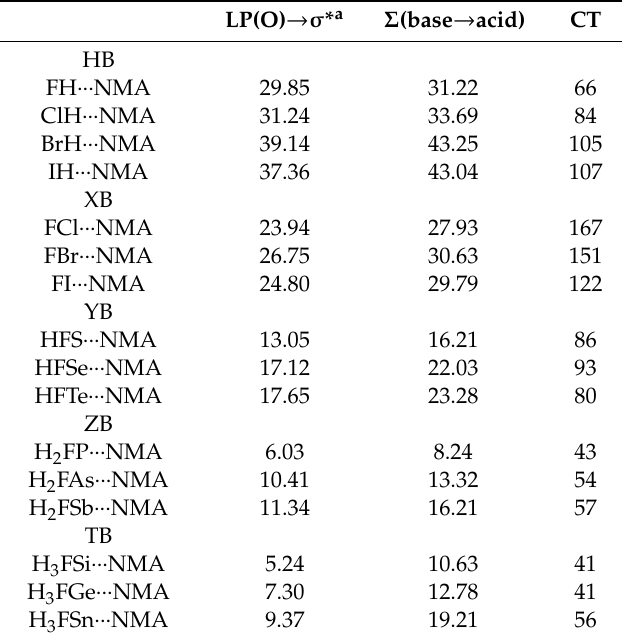
Table 6. NBO values (kcal / mol) of E(2) for LP(O) donation to the Lewis acid σ *, orbital sum of all E(2) between NMA and LA, and total charge transfer (CT, in me) from NMA to LA obtained at the BLYP-D3 / def2-TVZPP